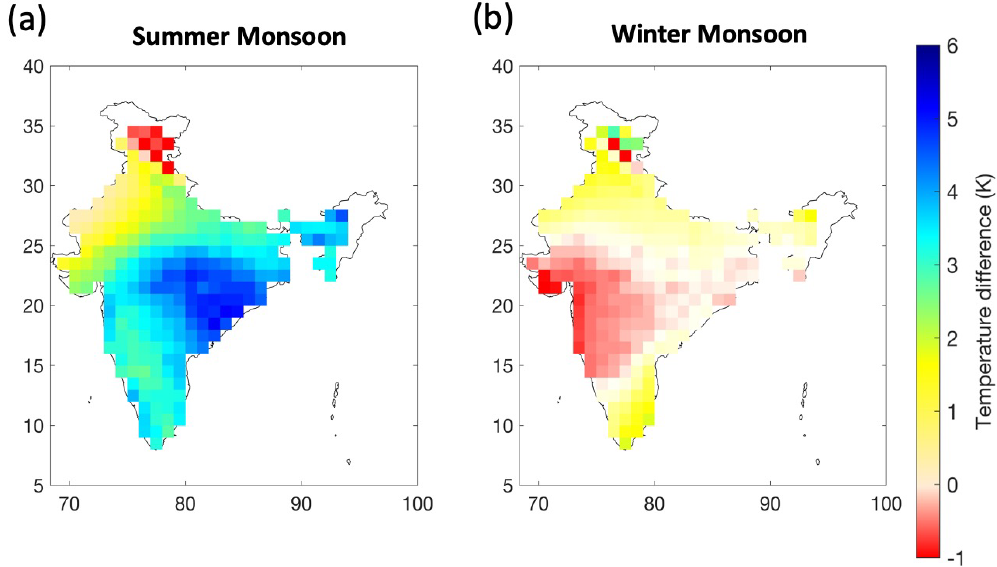
Figure C2. Maps of the cooling of surface due to clouds (defined as the difference between clear-sky and all-sky temperatures) for the